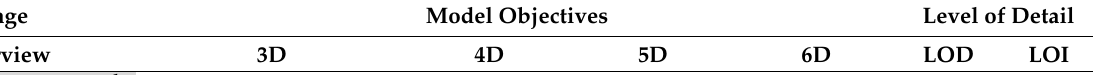
Table 5. Data Drops from the EIR for the Krakow Music